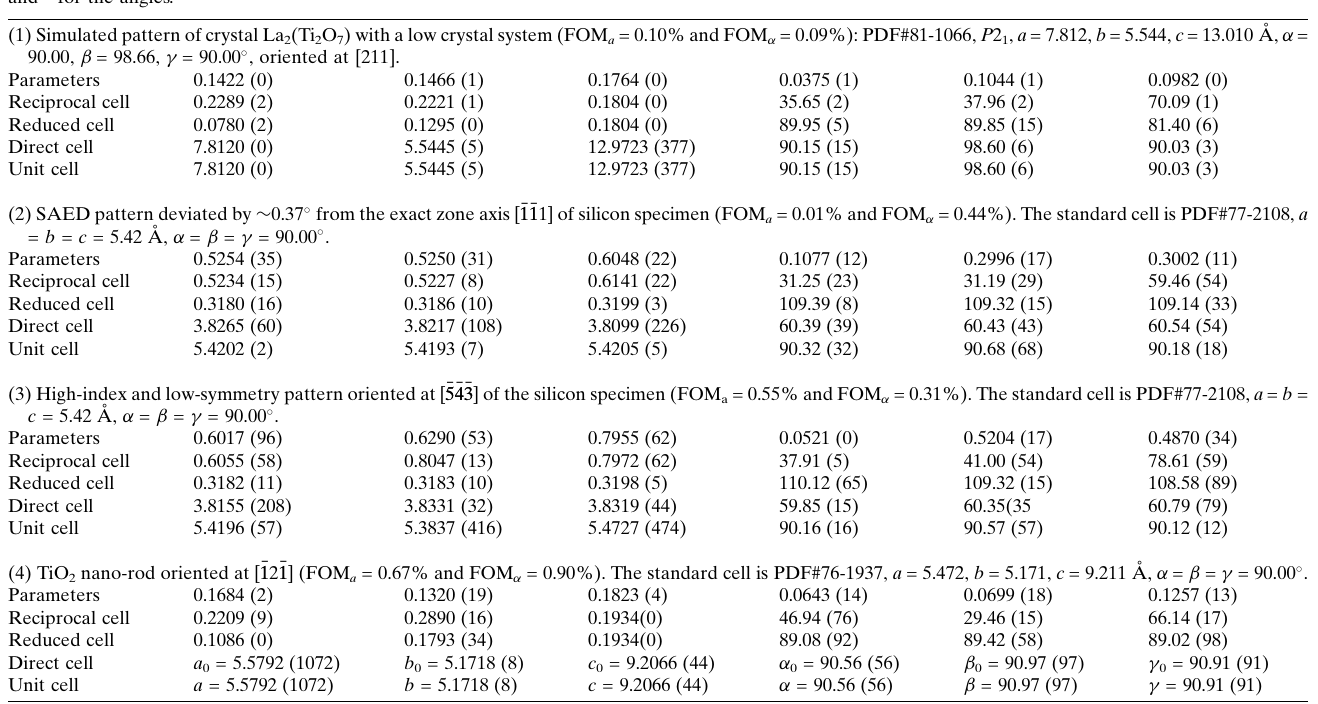
Table 1 Examples of unit-cell determination. The row ‘Parameters’ includes the parameters OA 1 , OB 1 , OC 1 , CC 1 , A 1 C 1 and B 1 C 1 , respectively. The units are A˚ (cid:3) 1 for the reciprocal space, A˚ for the real space and (cid:6) for the angles. (1) Simulated pattern of crystal La 2 (Ti 2 O 7 ) with a low crystal system (FOM a = 0.10% and FOM (cid:5) = 0.09%): PDF#81-1066, P 2 1 , a = 7.812, b = 5.544, c = 13.010 A˚ , (cid:5) = 90.00, (cid:6) = 98.66, (cid:4) = 90.00 (cid:6) , oriented at [211].